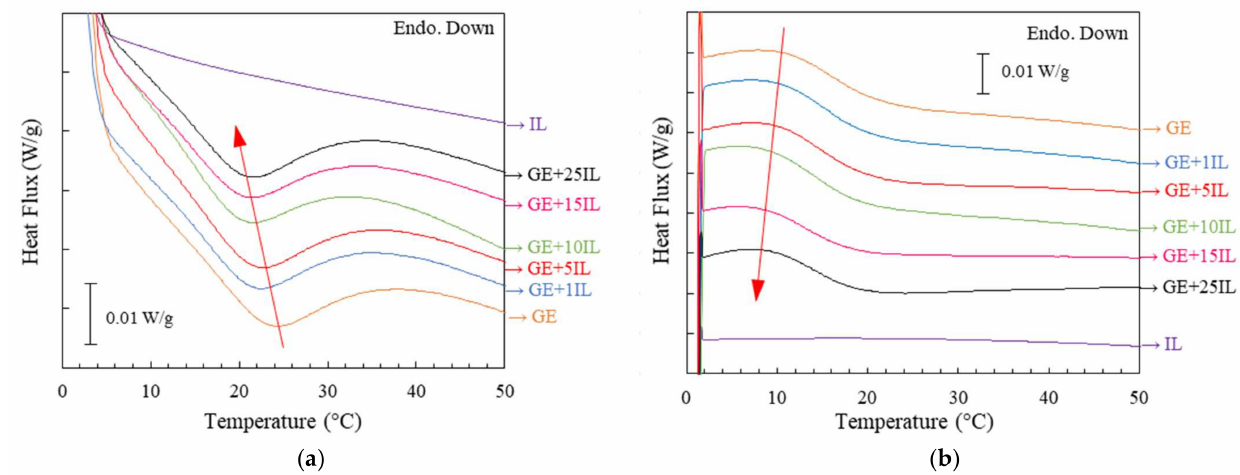
Figure 12. ( a ) Heating and ( b ) cooling thermograms of GE and Ionogels at 5 ◦ C/min. ( — ) GE, ( — ) GE/1IL, ( — ) GE/5IL, ( — ) GE/10IL, ( — ) GE/15IL, ( — ) GE/25IL and ( — )